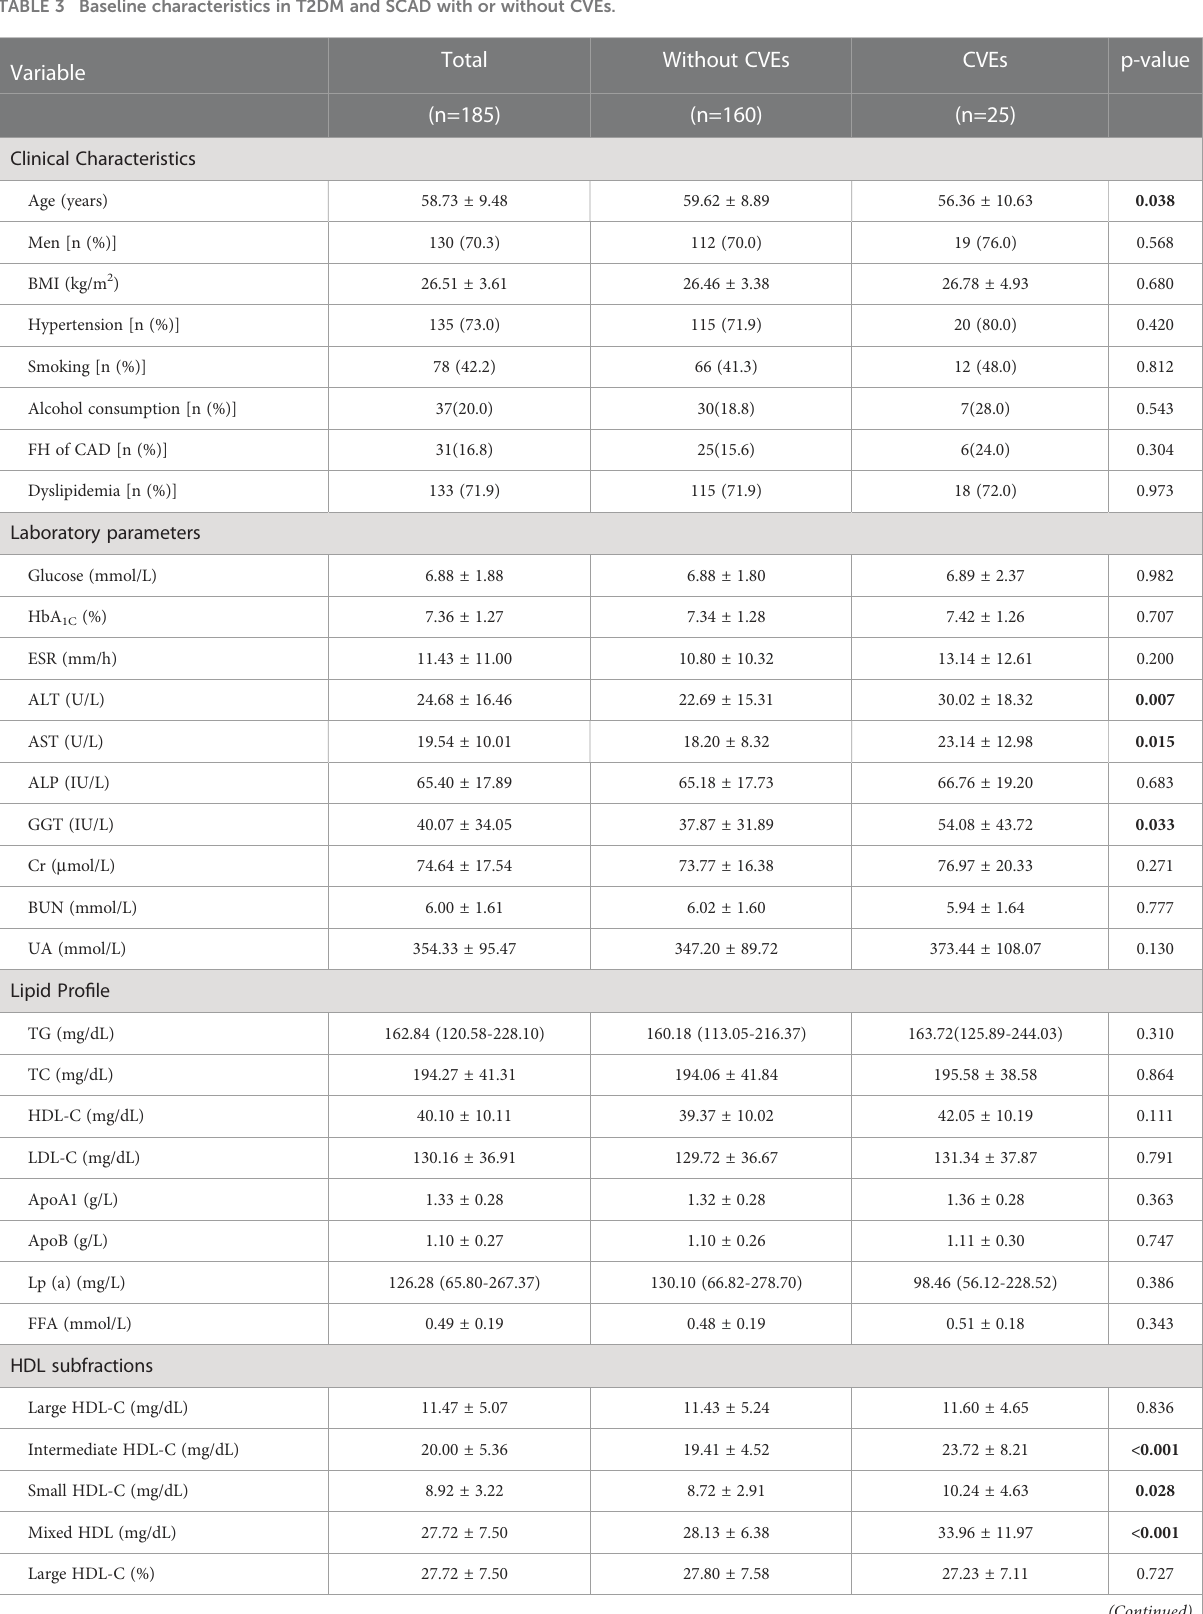
TABLE 3 Baseline characteristics in T2DM and SCAD with or without